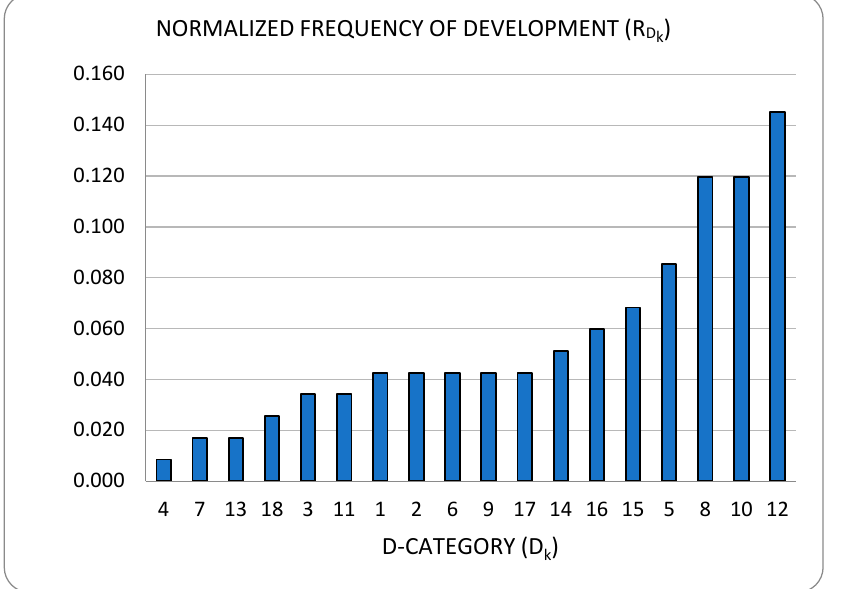
Figure 21. Approach metrics.